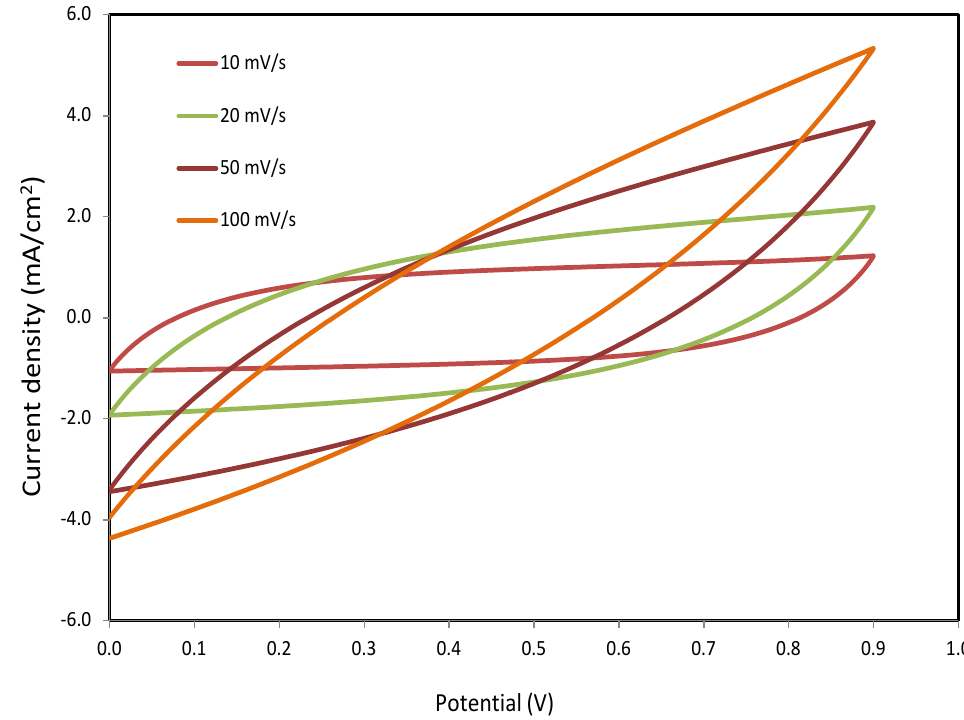
Figure 6. Cyclic voltammogram responses of the EDLC fabrication for the PVCH3 at different scan rates in the potential rage of 0 to 0.9 V.